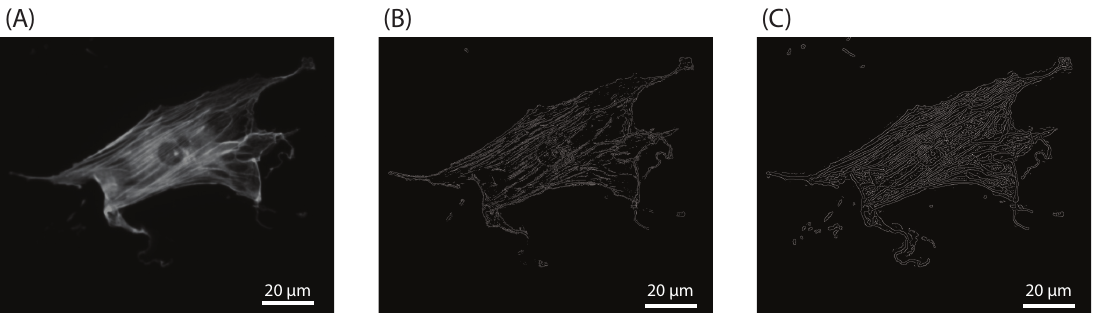
Figure 2. Image skeletonization: ( A ) the converted fixed-cell image of an untreated cell in grayscale; ( B , C ) are the skeletonized image of (A) using Sobel and Canny edge detectors,